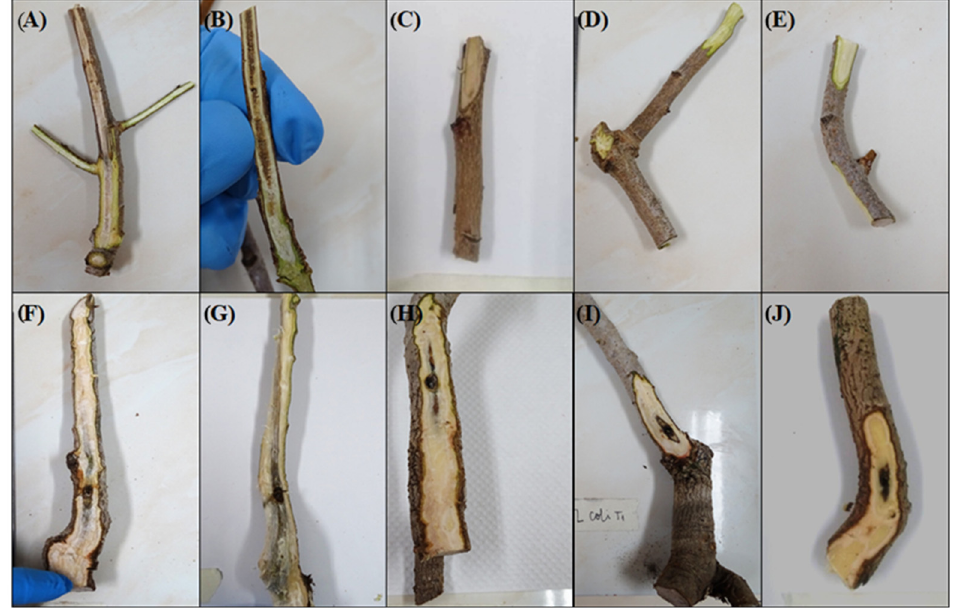
Figure 4. Experimentally inoculated pistachio plants after thirty-one weeks. Necrosis in longitudinal section of a twig inoculated ( A ) with isolate OF148 (T1) and ( B ) with isolate OF151 (T3). Necrosis in longitudinal section of a trunk sample ( F ) with isolate OF148 (T2) and ( G ) with isolate OF151 (T4). ( C , H ) Control twig inoculated with culture medium. ( D , I ) Control twig inoculated with E. coli . ( E , J ) twig wound control.